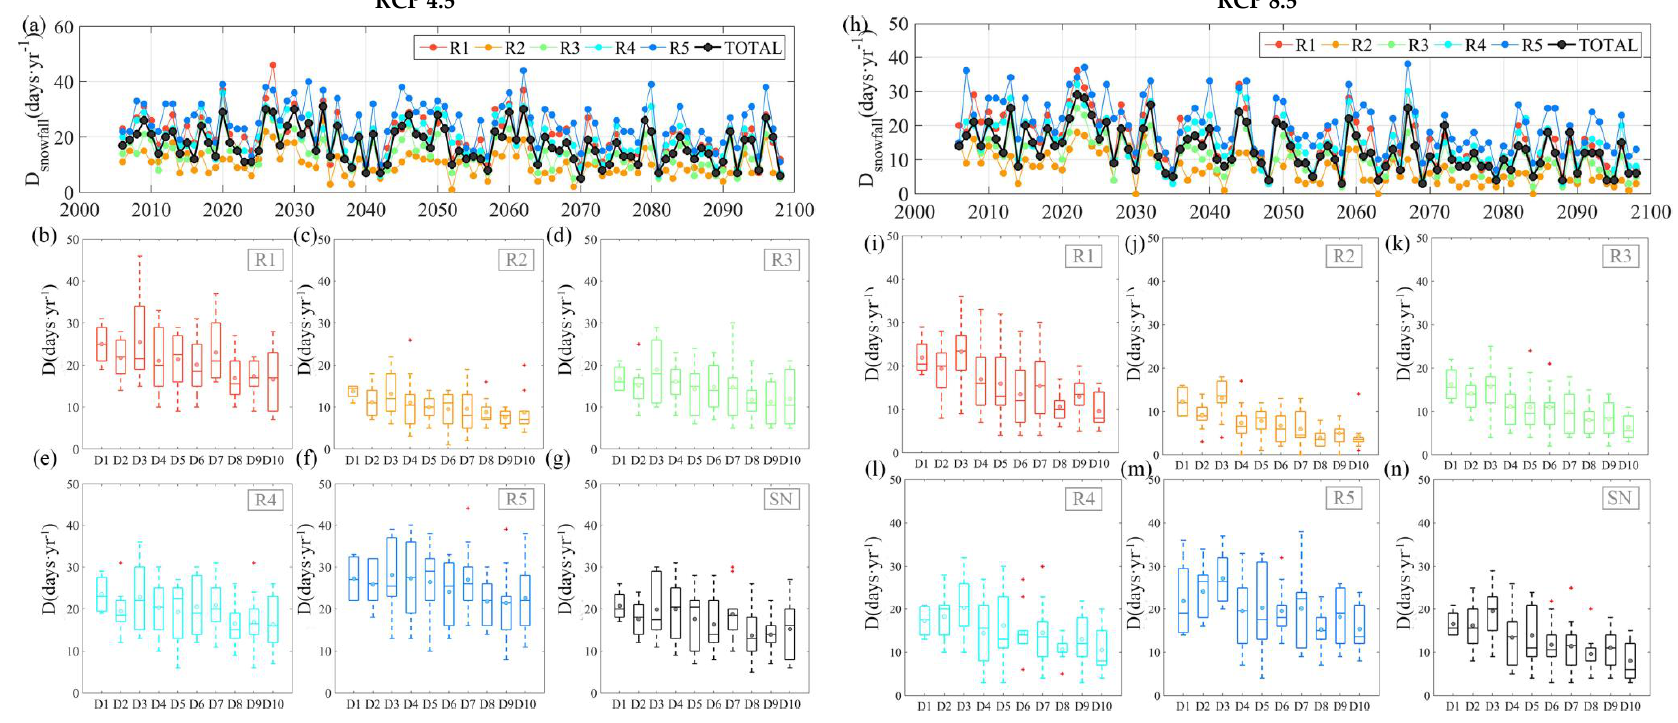
Figure 9. Annual evolution of the annual snowfall days indicator (Dsnowfall) during the 2006–2100 future study period for ( a ) RCP 4.5 and ( h ) RCP 8.5, averaged over each region in Sierra Nevada (Figure 1) and the whole study area. Decadal evolution of the mean annual snowfall anomalies during the study period in Sierra Nevada for RCP 4.5: ( b ) Region 1, ( c ) Region 2, ( d ) Region 3, ( e ) Region 4, ( f ) Region 5, and ( g ) the total study area, and the decadal evolution for RCP 8.5: ( i ) Region 1, ( j ) Region 2, ( k ) Region 3,( l ) Region 4, ( m ) Region 5, and ( n ) the total study